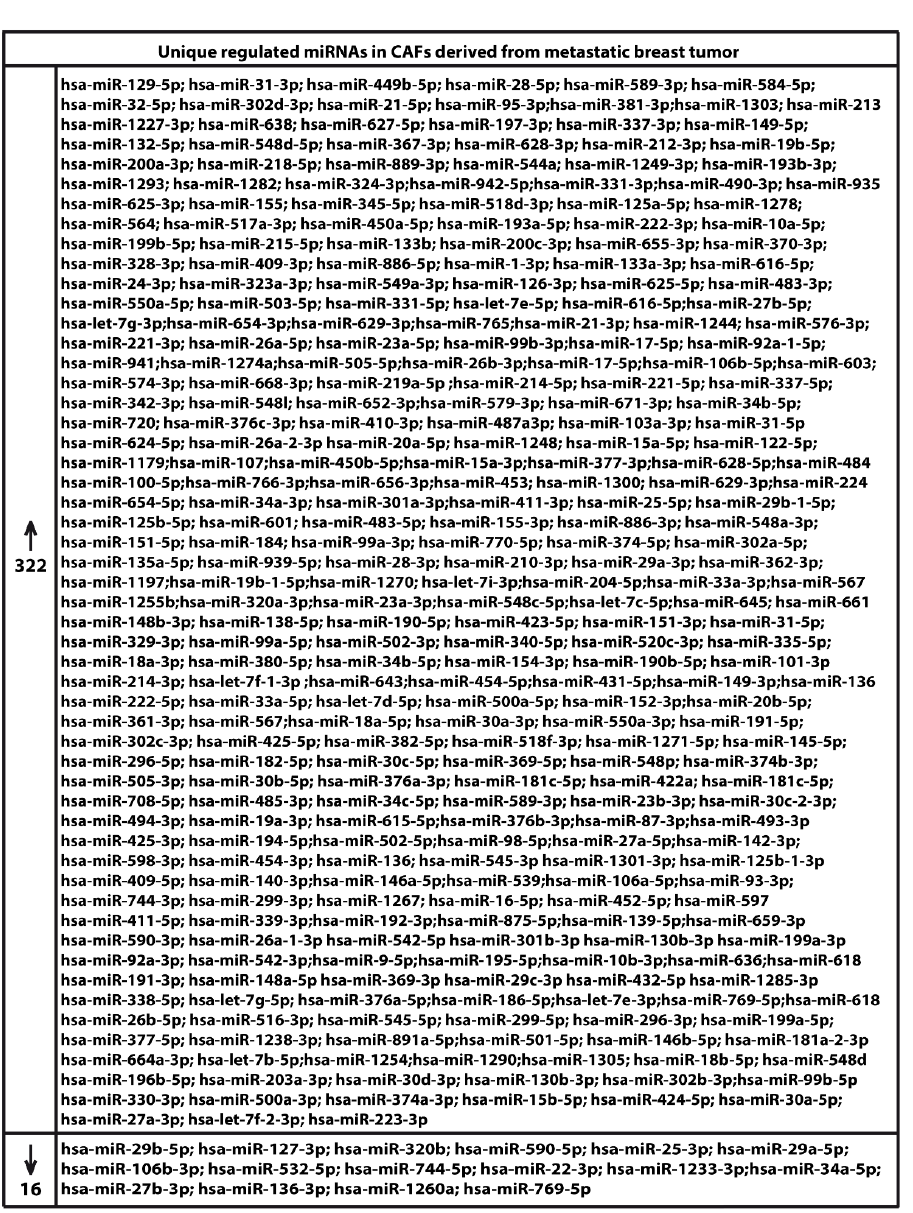
Figure 10. Up and downregulation of unique miRNAs in CAFs derived from a cutaneous metastasis of breast tumor and treated for 4 h with 100 nM E2.